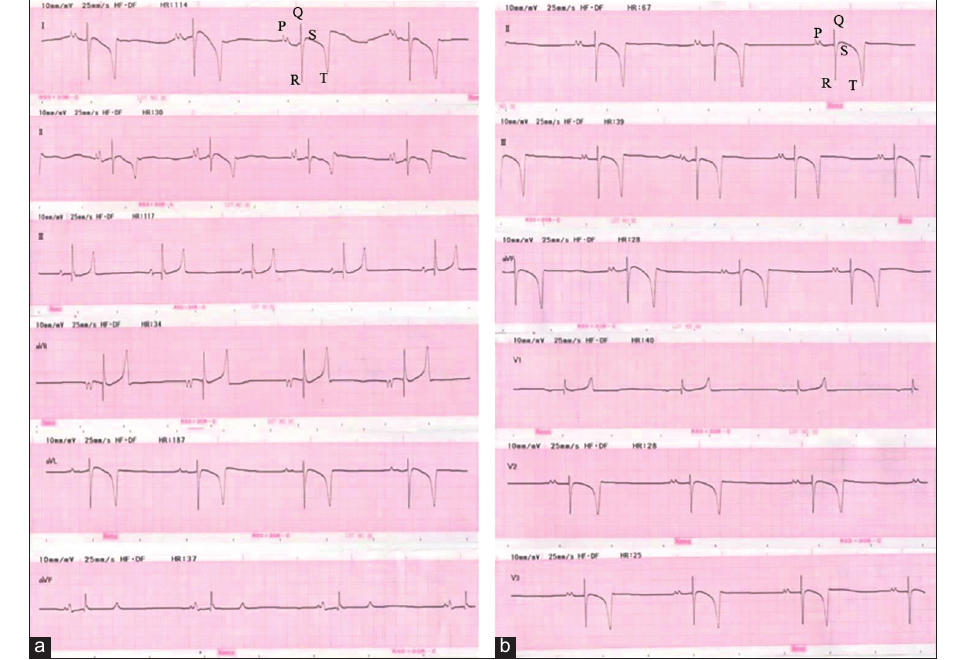
a Figure-2: A section of base apex (a) and modified precordial lead (b), Electrocardiography signal such as P, Q, R, S, and T wave were obtained from the recording. Table-2: Electrocardiography measurements. Lead system